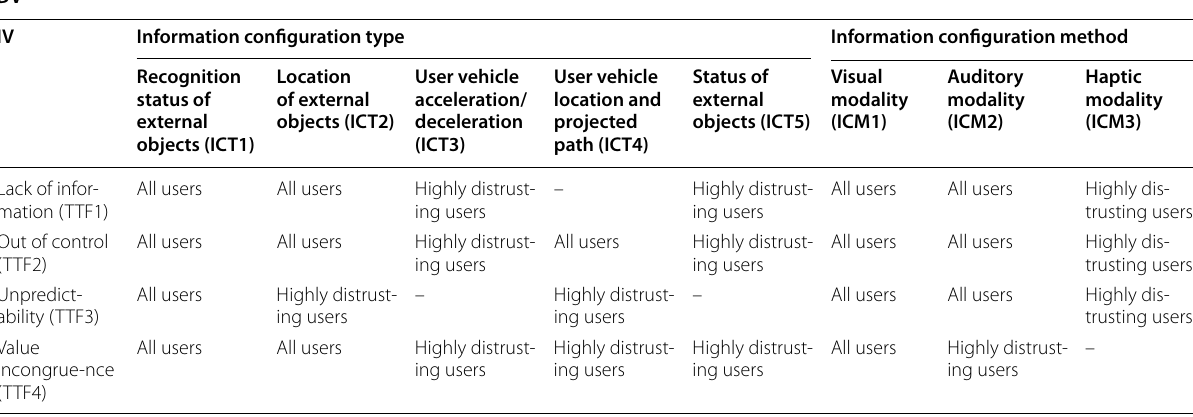
Table 7 Information configuration according to